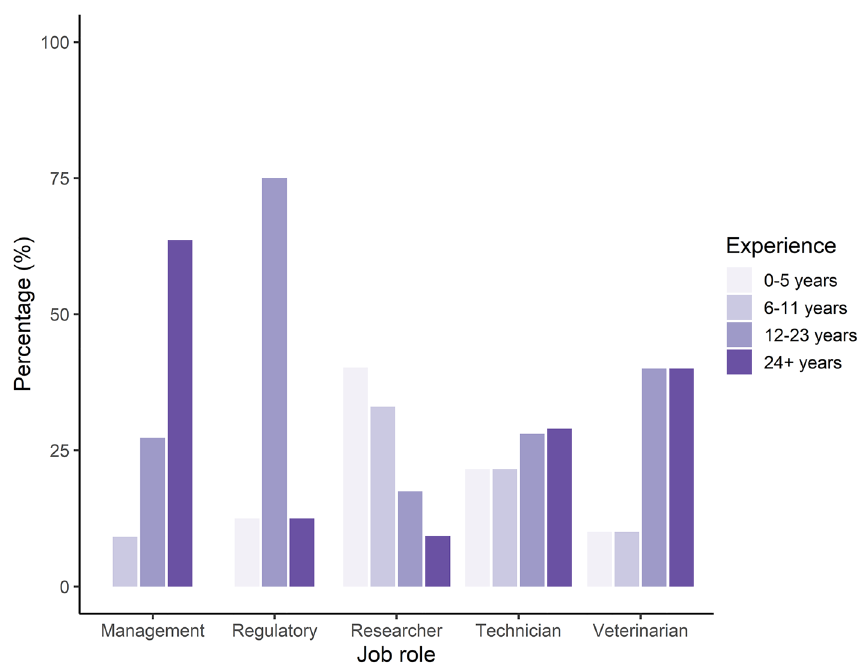
Figure 1. Percentage (%) of a total of 219 participant responses within each current job role according to their duration of experience of working with laboratory